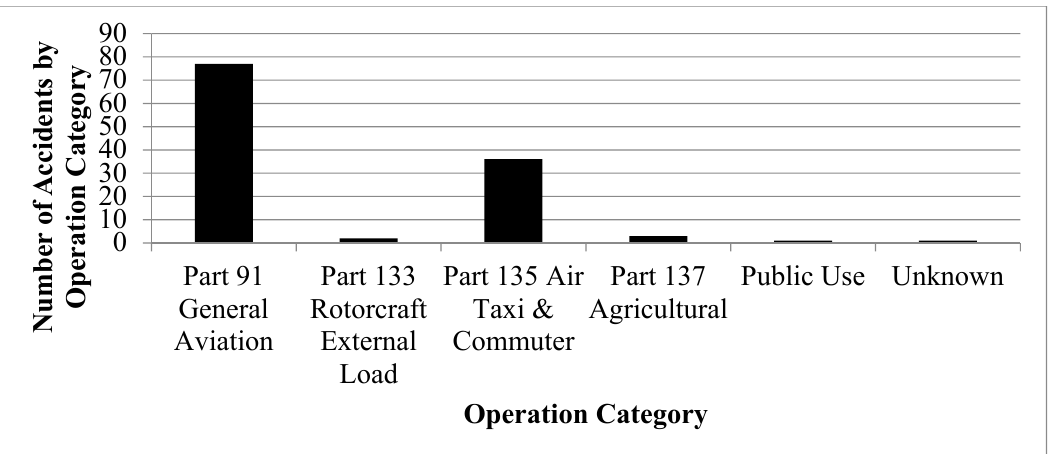
Figure 2. Number of Accidents by Operation Category. Table 2. Flight rules reported for fog-related helicopter accidents.